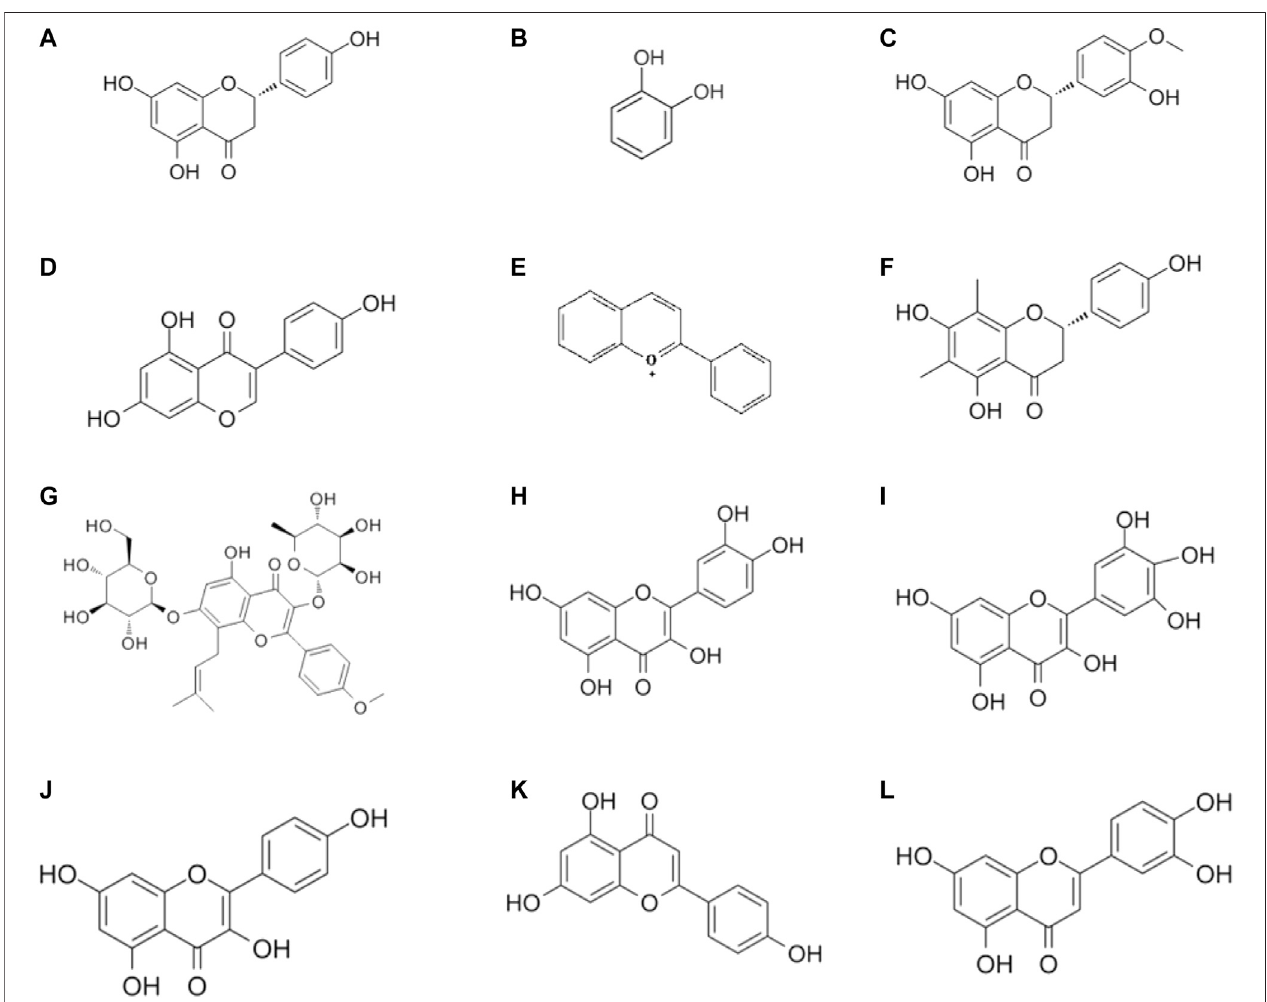
FIGURE2| Chemicalstructuresof fl avonoidphytochemicals: (A) Naringenin (B) Catechins (C) Hesperetin (D) Genistein (E) Anthocyanin (F) Farrerol (G) Lcariin (H) Quercetin (I) Myricetin (J) Kaempferol (K) Apigenin (L) Luteolin.